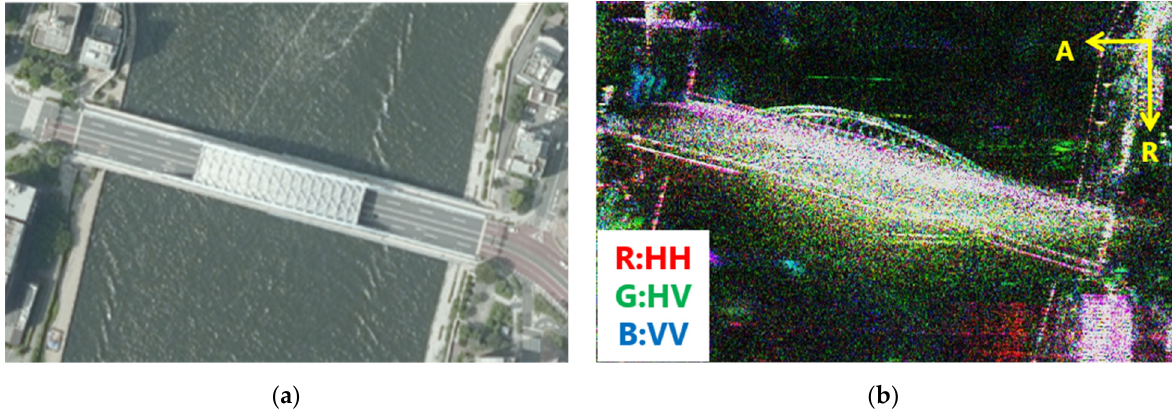
Figure 3. An arch bridge over the Sumida River in Tokyo, Japan: ( a ) aerial photo taken by the Geospatial Information